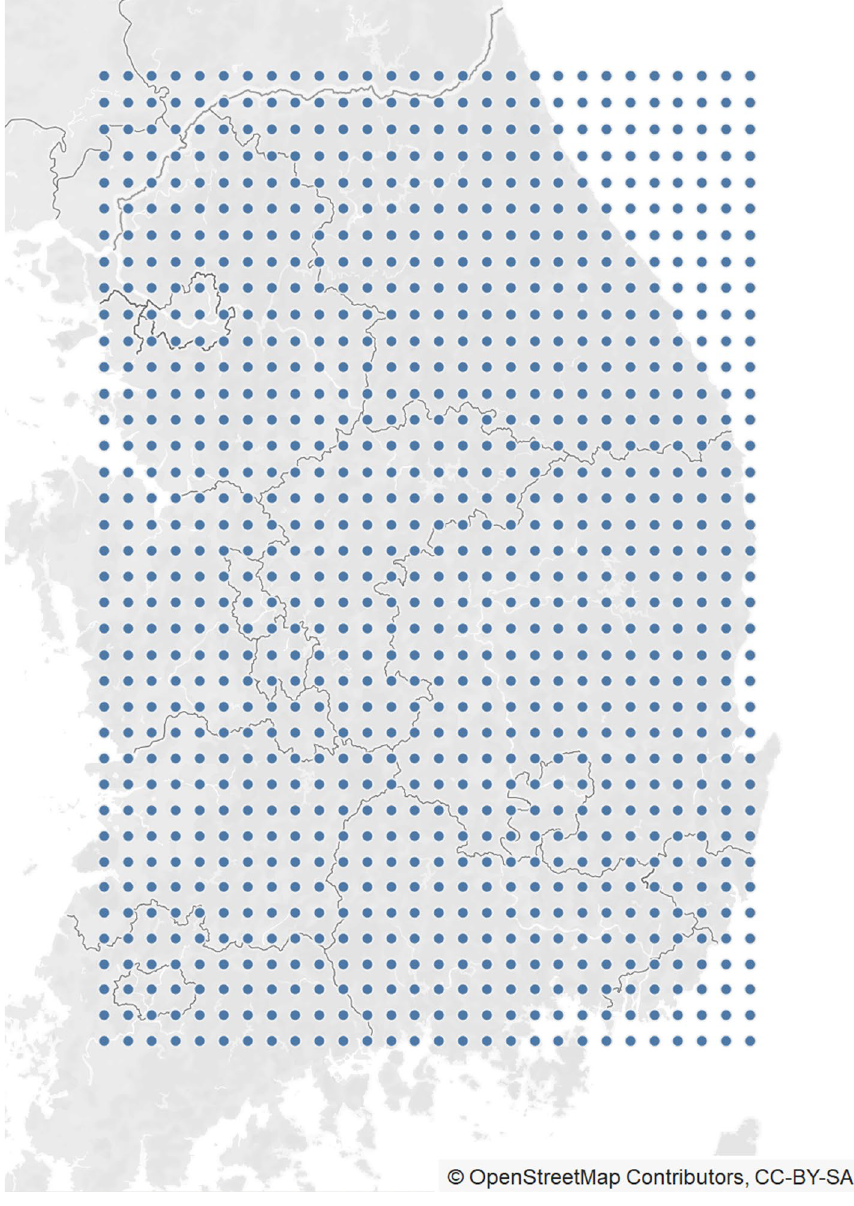
Figure 1. Locations of gridlines for ICNN. Map image is obtained from OpenStreetMap (openstreetmap.org) and licensed under CC-BY-SA (https:// www. opens treet map. org/ copyr